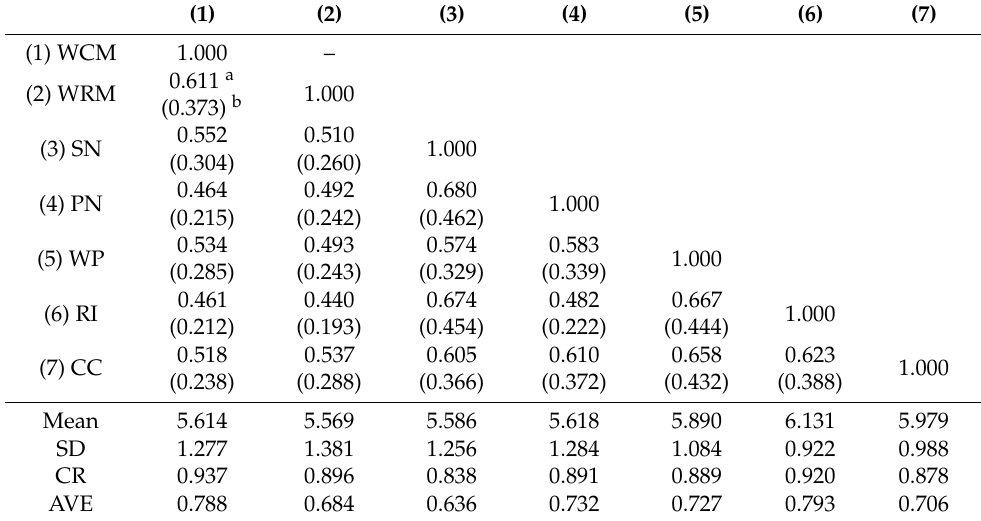
Table 1. Measurement model results and